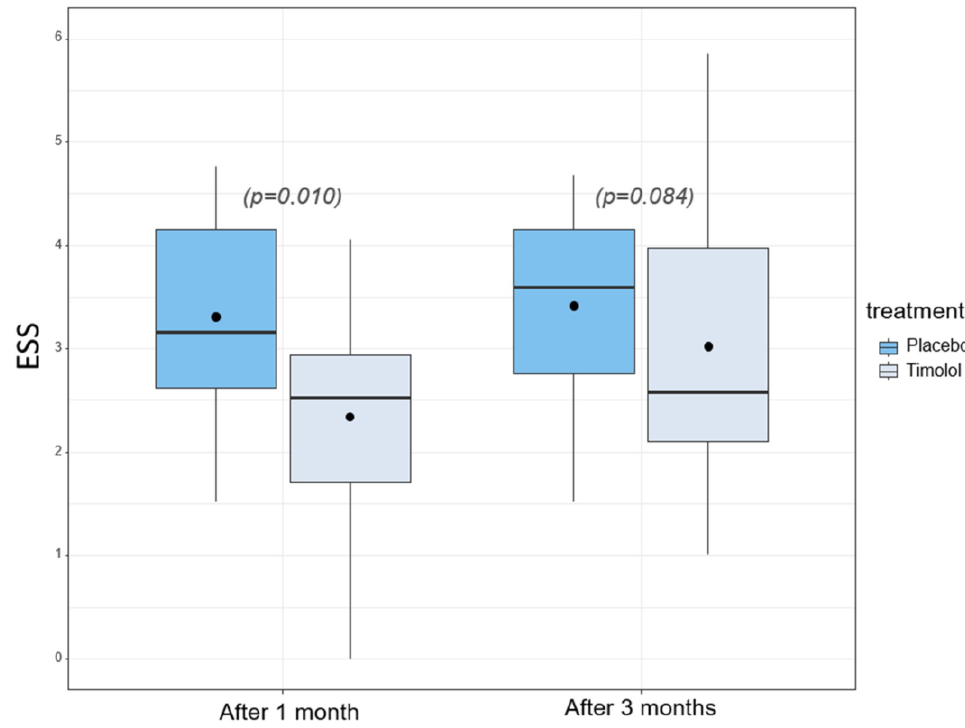
Figure 3. Change in Epistaxis Severity Score after one and three months in the TIM-HHT study. Table 2. Primary endpoint, ESS after 3 months.